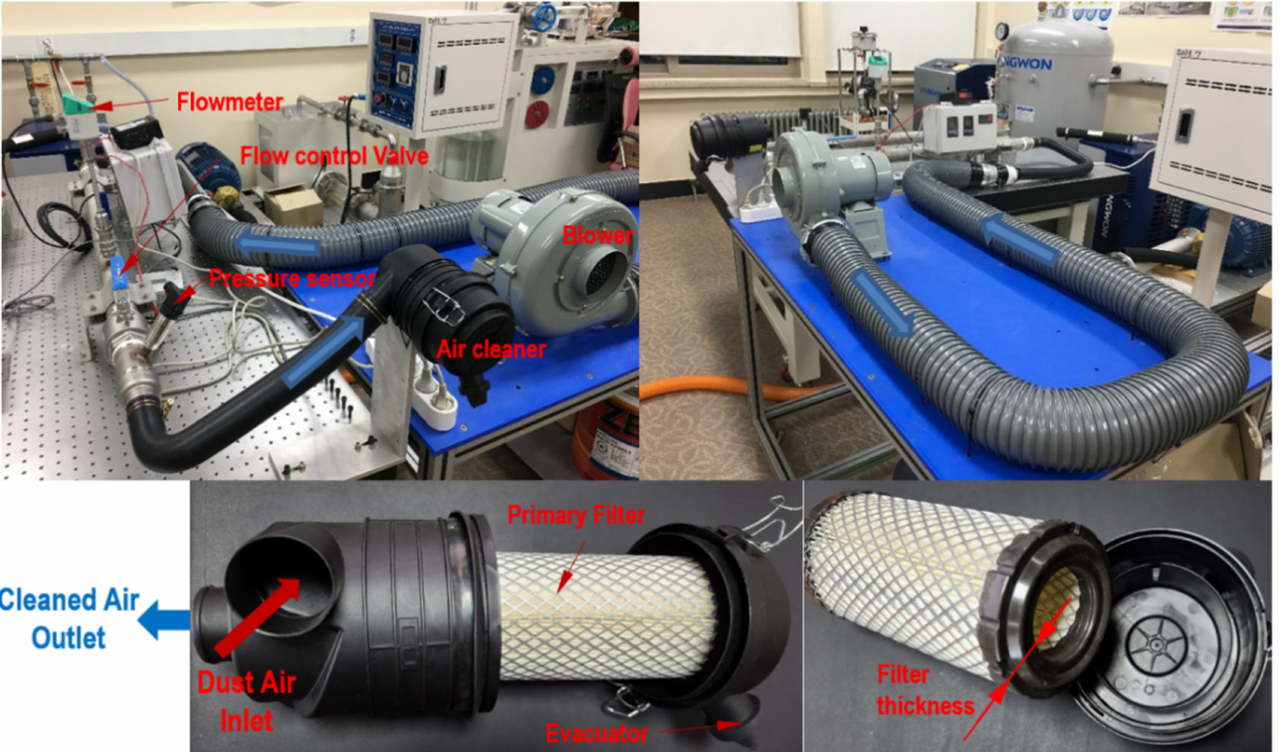
Figure 6. Test rig with air cleaner used to determine the flow characteristics of primary filter.